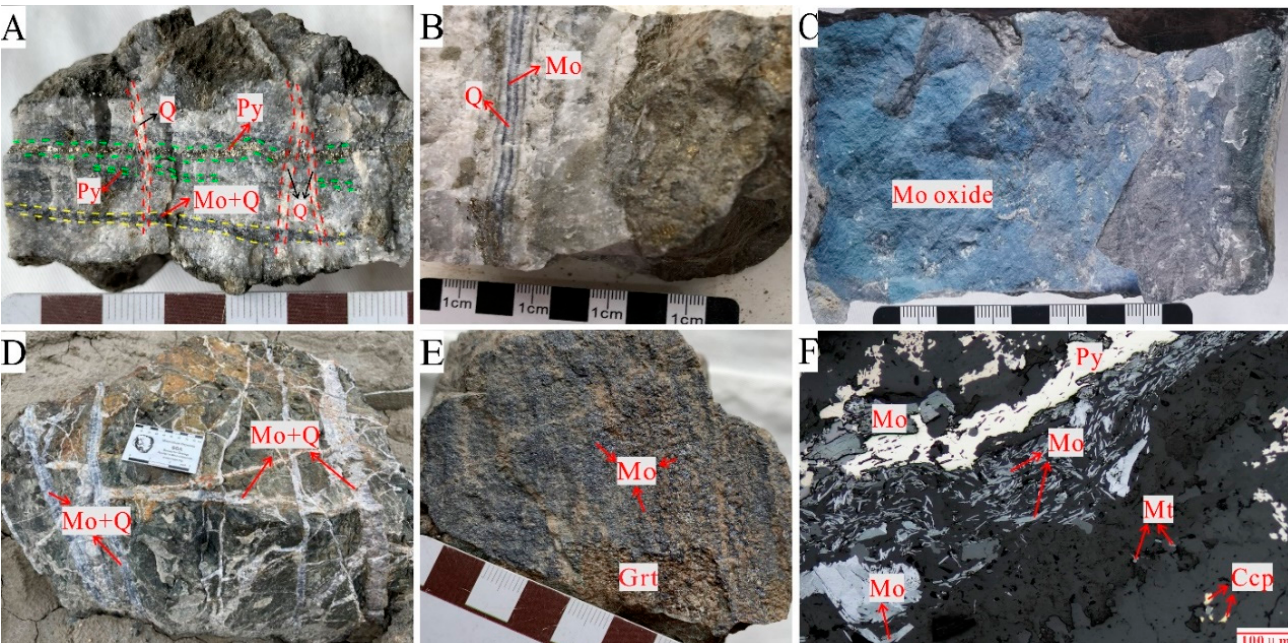
Figure 4. Photographs of ore petrography of the Shangfanggou Mo–Fe deposit: ( A ) quartz– molybdenite veinlet and pyrite veinlets crosscut by the late quartz veinlet; ( B ) banded structure; ( C ) membranous structure of the Mo oxide ore; ( D ) stockwork structure showing multistage mineralization; ( E ) disseminated Mo mineralization in the garnet-skarns; ( F ) the curved lepidosome molybdenite and paragenetic pyrite, magnetite, and chalcopyrite unevenly distributed between gangue minerals. Abbreviations: Q, quartz; Mo, molybdenite; Py, pyrite; Grt, garnet; Mt, magnetite; Ccp, chalcopyrite.